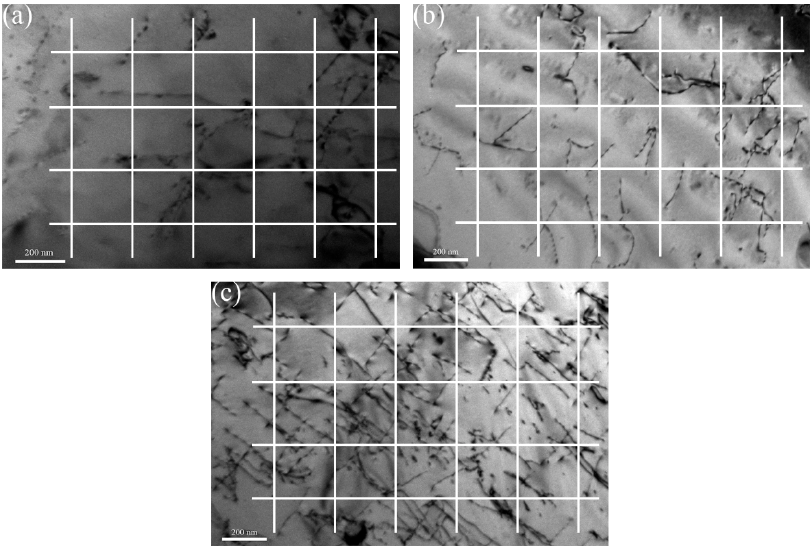
Figure 4. Sketch of the method for the measurement of dislocation density in: ( a ) 16Cr ODS steel; ( b ) 16Cr-0.3Zr ODS steel; and ( c ) 16Cr-0.6Zr ODS steel.